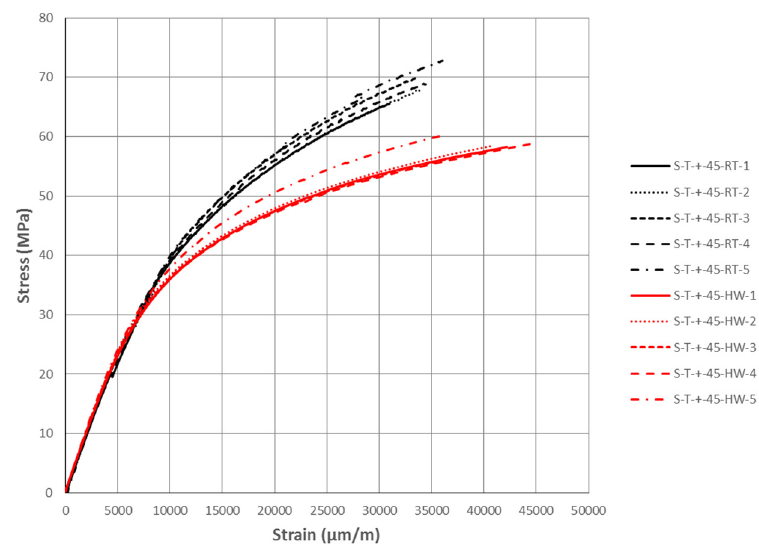
Figure 7. E ff ect of aging on stress–strain curves of in-plane shear strength (IPSS) test. Figure 7. Effect of aging on stress–strain curves of in-plane shear strength (IPSS) test.